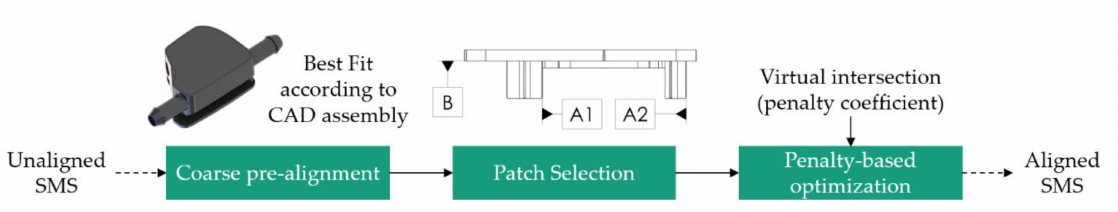
Figure 7. Virtual Assembly Surrogate Model used for the considered use